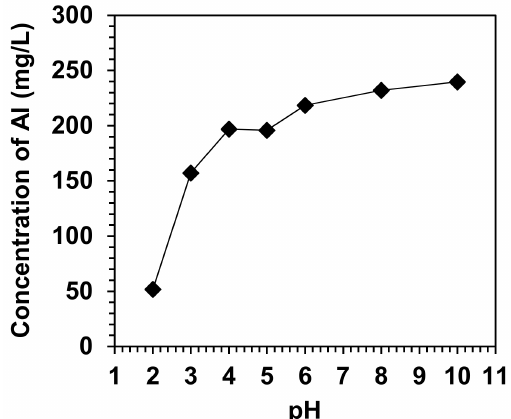
Figure 6. Concentration of Al in solution after filtering with a 2 um filter at different pH values ranging from 2.0 to 10.0.